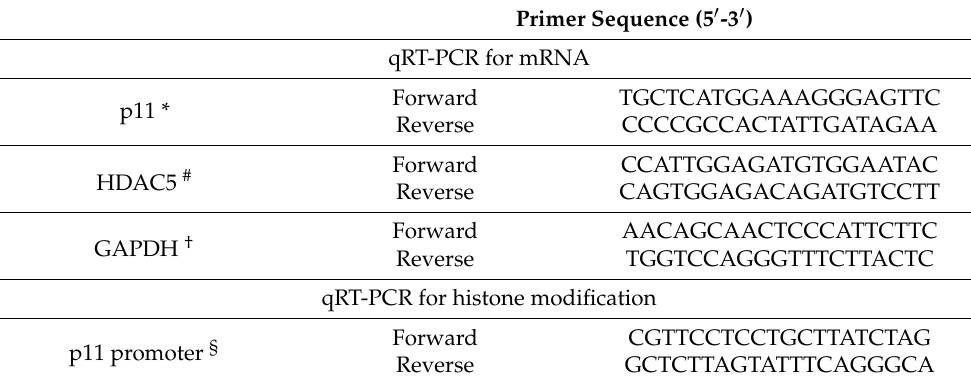
qRT-PCR for histone